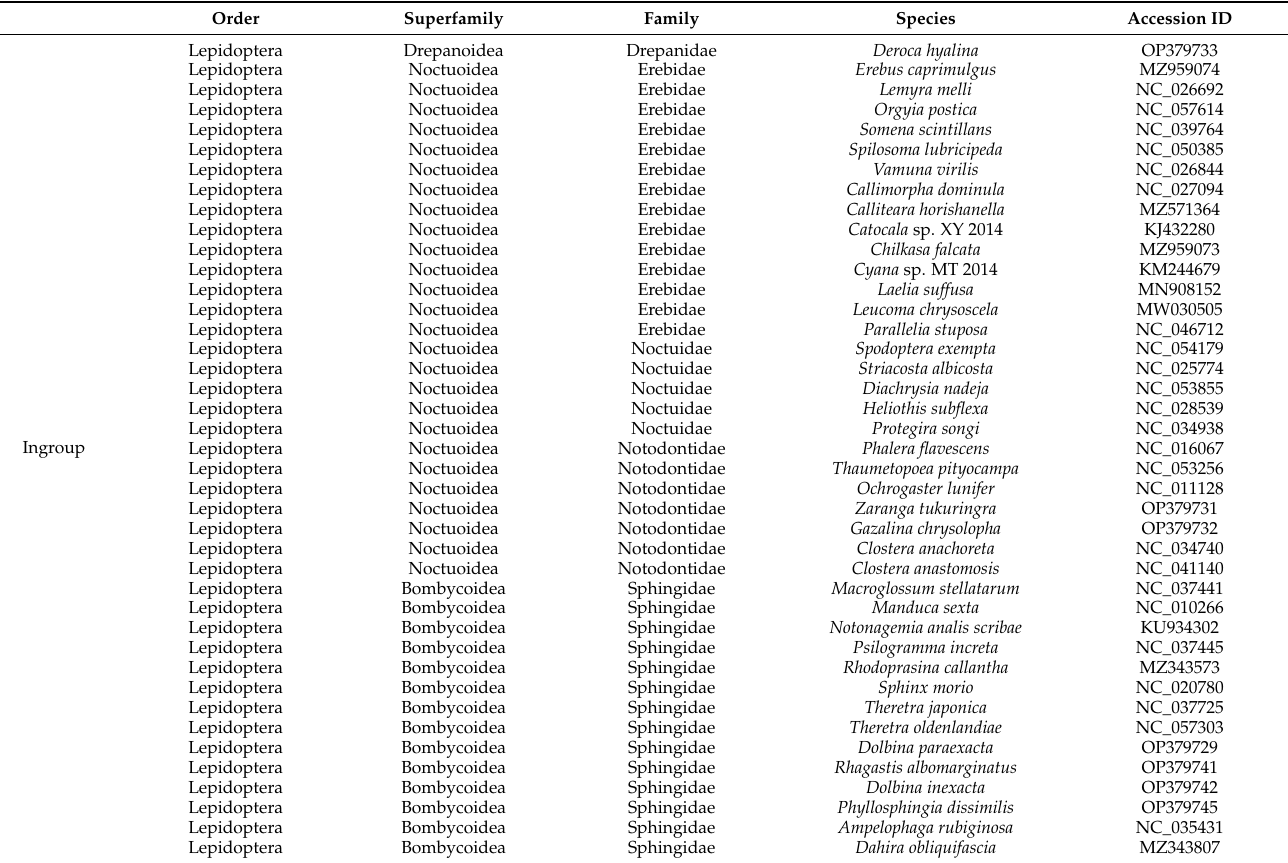
Table 1. Species information of mitochondrial phylogenetic